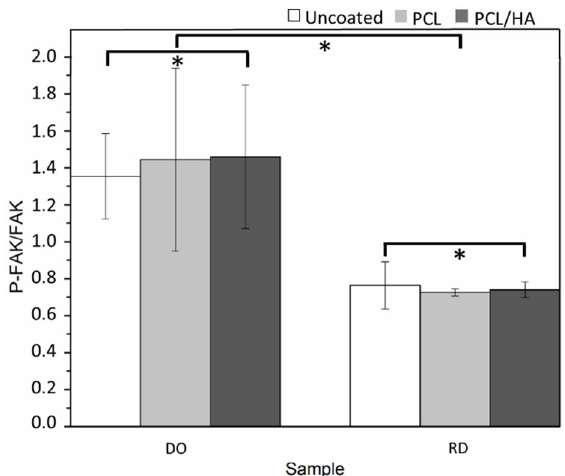
Figure 12. The activation level of FAK was measured by ELISA assay after 24h of incubation onto the different scaffolds. Bar graphs show P-FAK values normalized on the total FAK— p < 0.05